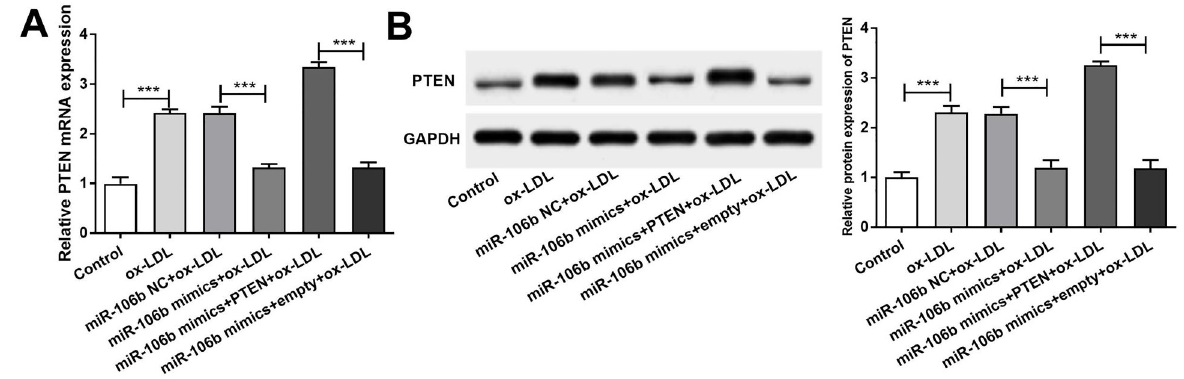
Figure 3. A , mRNA expression level of PTEN in the different groups of cells. B , Protein expression level of PTEN. Data are reported as means ± SD. ***P o 0.001 (ANOVA). ox-LDL: oxidized-low-density lipoproteins; NC: negative